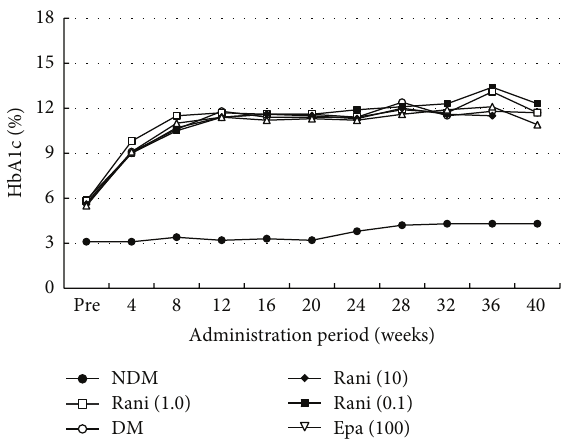
Figure 3: HbA1c levels during the experiment. The mean HbA1c levels of the SD rats are significantly lower than those of the SDT rats with or without treatment. There is no significant difference in the HbA1c levels among the SDT rats with or without treatment. NDM: non-diabetes mellitus; DM: diabetes mellitus; rani: ranirestat; epa: epalrestat.